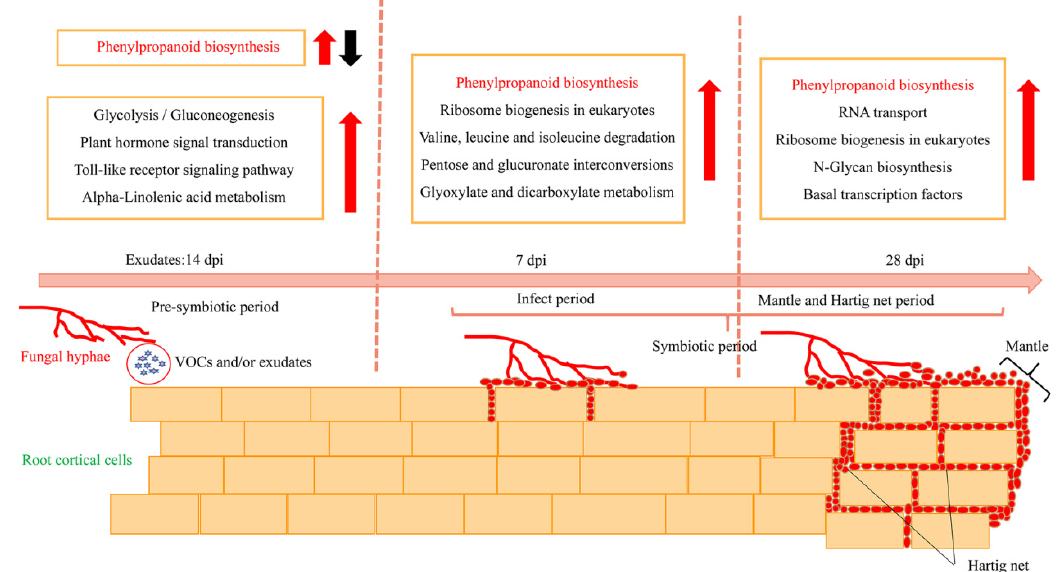
Figure 9. Schematic diagram showing morphological and transcriptional changes in a P. massoniana root during the formation of an ECM symbiosis with S. bovinus . Red arrows indicate upregulation; black arrow indicates downregulation. The phenylpropanoid biosynthesis pathway is common to all three ECM stages.